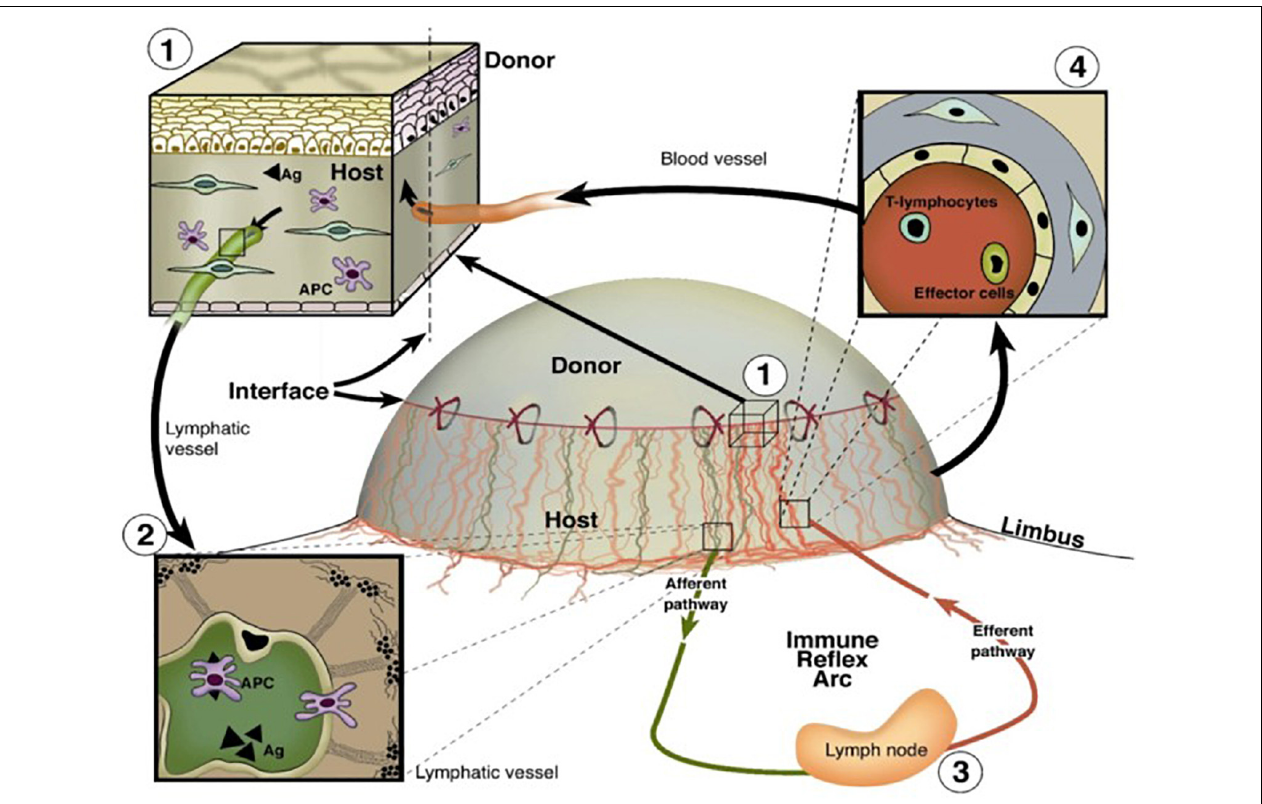
FIGURE 5 | Important roles of BVs and LVs in the high-risk corneal host bed as exit and entry routes of the immune reflex arc leading to immunologic graft rejection, reproduced from Clahsen et al. (2020). (1) Magnification of the host–graft interface where BVs (red) and LVs (green) reach the graft. (2) Antigen (Ag) and APCs both of host and donor can leave the cornea using corneal lymphatics and migrate through corneal LVs to the draining lymph nodes. (3) After stimulation of immune effector cells in the regional lymph nodes, (4) T lymphocytes/effector cells can be released via the efferent blood vessels and gain direct access to the transplant to initiate a rejection reaction (efferent arm of the immune reflex